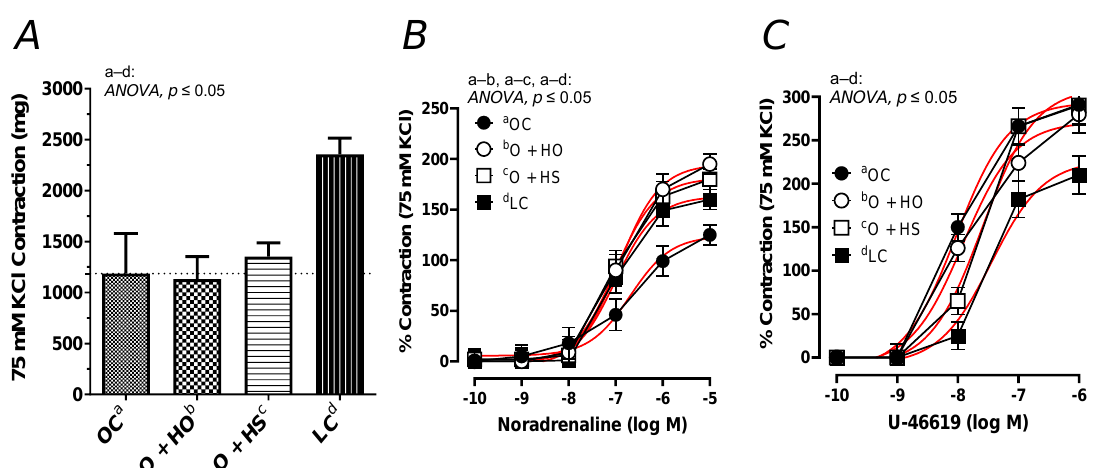
Figure 8. The contractile response of isolated thoracic arteries from 8-week-old lean (LC) and obese (OC) Zucker rats fed a diet containing hemp seed oil (HO) and hemp seeds (HS) for 4 weeks. Vascular contraction was induced by potassium chloride (75 mM KCl) ( A ), noradrenaline (0.1 nM–10 μM) ( B ), and a thromboxane-A 2 analog (U-46619, 0.1 nM–1 μM) ( C ). Results (means ± SEM) are expressed in mg of tension and as a percentage of the previous tone elicited by 75 mM KCl. p ≤ 0.05 (two-way ANOVA/Sidak’s), n = 6. HO and HS improved contraction to noradrenaline.